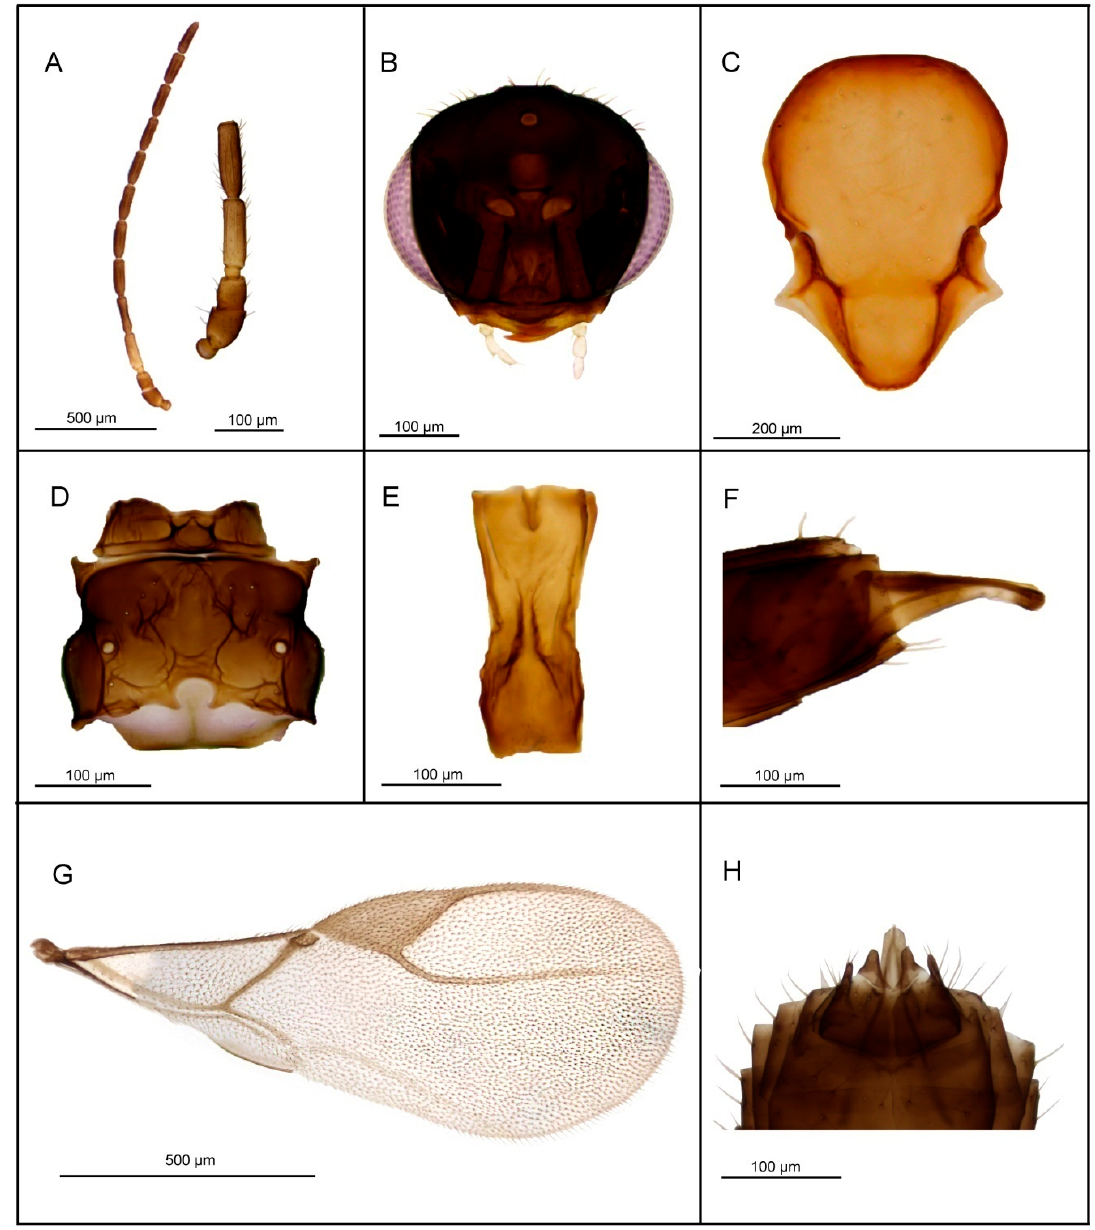
Figure 10. Lipolexis gracilis: female ( A ) antenna and F1 and F2; ( B ) head; ( C ) mesoscutum; ( D ) propodeum; ( E ) petiole, dorsal view; ( F ) ovipositor sheath; ( G ) forewing; male ( H ) aedeagus.